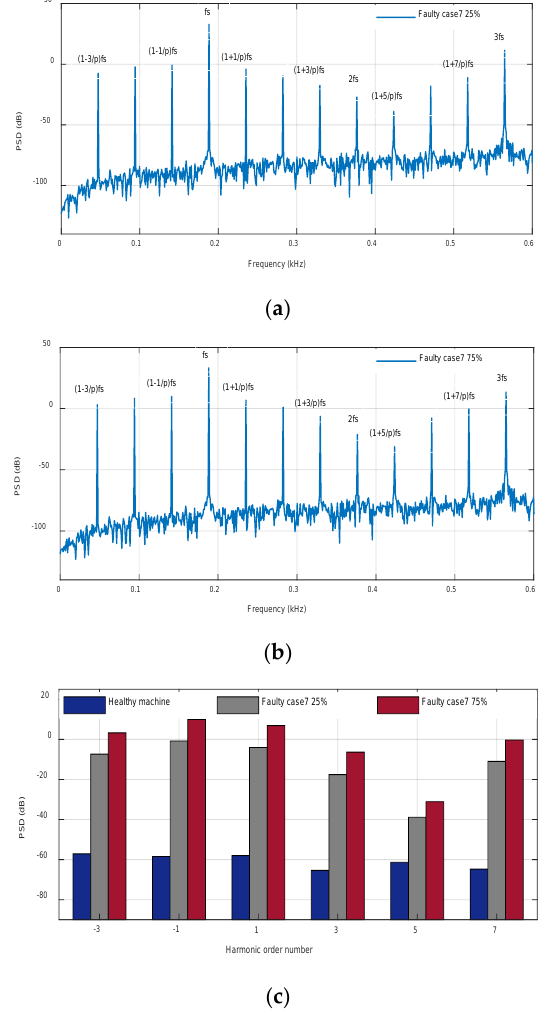
Figure 29. Faulty case 7: ( a ) PMSM current spectra normalized plot under 25%; ( b ) PMSM current spectra normalized plot under 75%; ( c ) ASBCs harmonics variations.